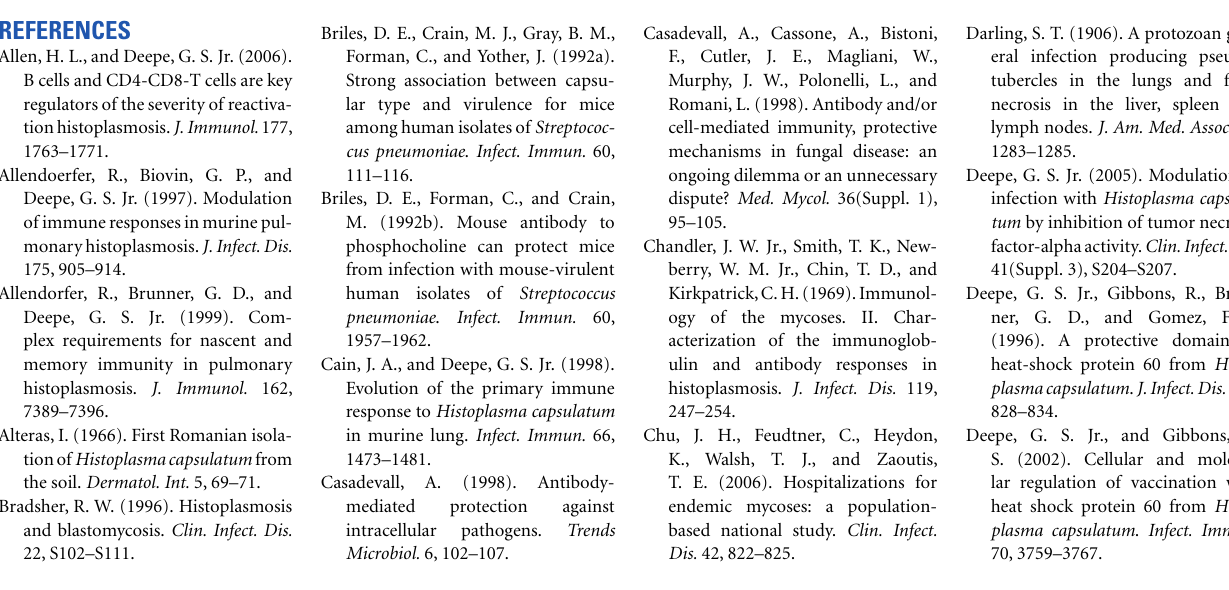
FIGURE 2 | Monoclonal antibodies (mAbs) to the M antigen can modify the pathogenesis of experimental histoplasmosis. The generation of the mAbs is described in Guimaraes et al. (2008).The mAbs produced are mAb 7C7 (IgM isotype), mAb 6F12 (IgG2a), and mAb 8H2 (IgG2a). Using methods described in Guimaraes et al. (2011b), the phagocytosis rates (A) , and killing capacity (B) of J774.16 macrophage-like cells reveal that the mAbs